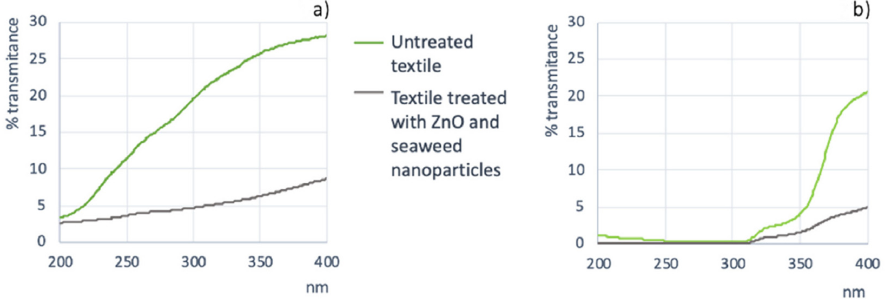
Figure 7. Percentage of transmittance spectra of the textiles tested: ( a ) cotton; ( b ) polyester. The green lines represent the control (untreated) textiles, and the grey lines represent the textiles treated by coating with the zinc oxide nanoparticles solution with Gelidium corneum extracts.